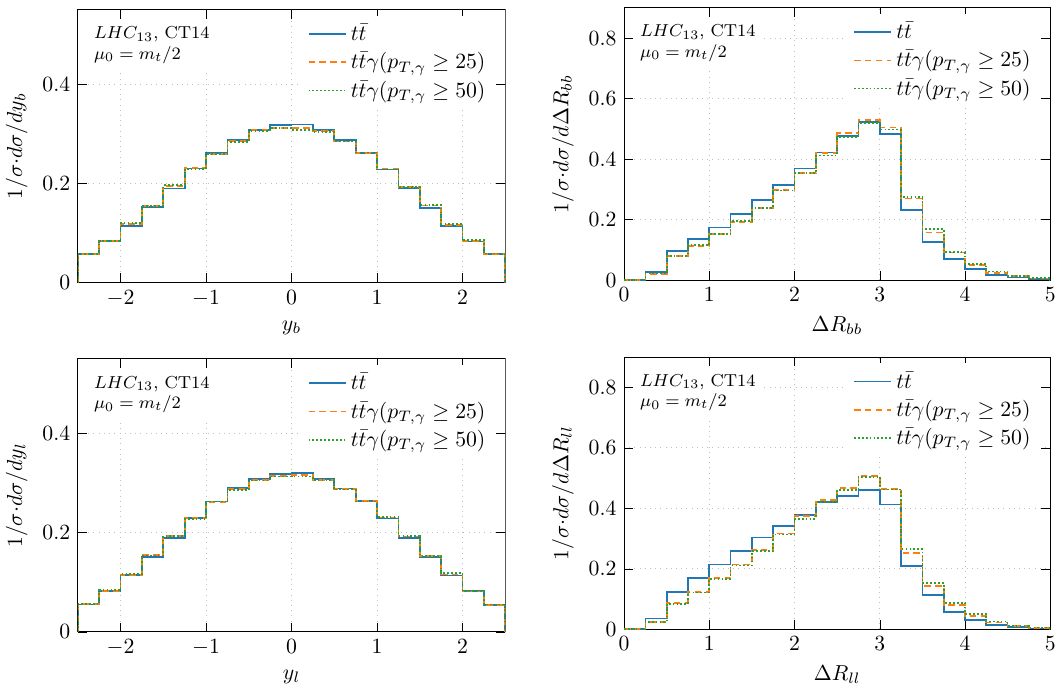
Figure 1 . Comparison of the normalised NLO di(cid:11)erential cross sections for pp and pp e + (cid:23) e (cid:22) (cid:0) (cid:22) (cid:23) (cid:22) b (cid:22) b + X at the LHC with p s = 13 TeV. We present: the averaged rapidity of the ! b -jet ( y b ), the distance in the azimuthal angle rapidity plane between two b -jets ((cid:1) R bb ), the averaged rapidity of the charged lepton ( y ‘ ) as well as the distance in the azimuthal angle rapidity plane between two charged leptons ((cid:1) R ‘‘ ). Results for two di(cid:11)erent values of the transverse momentum cut on the hard photon are shown. The NLO CT14 PDF set is employed and (cid:22) R = (cid:22) F = (cid:22) 0 = m t = 2 is